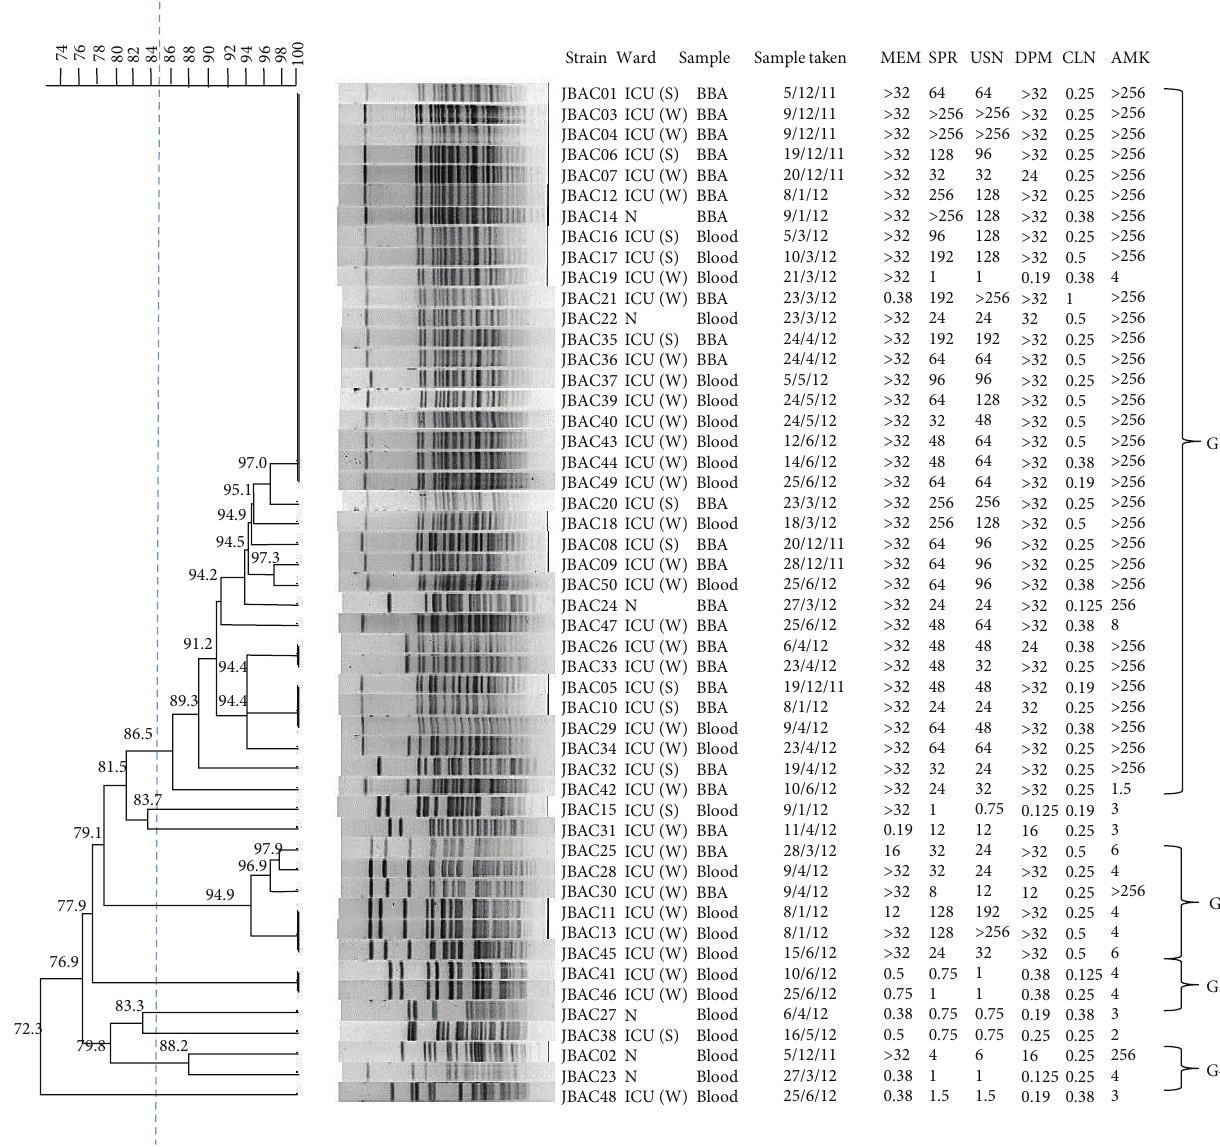
Figure2:DendrogramofthePFGEprofilesof Apa I-digested50ACBcomplexisolatesusingUnweightedPairGroupMethodwithArithmetic Averages (UPGMA). The dotted vertical line indicates the cut-off point of 85% similarity. The different clusters at 85% similarity are arbitrarily designated G1–G4, whereby G1 is the largest group representing the most prevalent pulsotypes and its variants among the